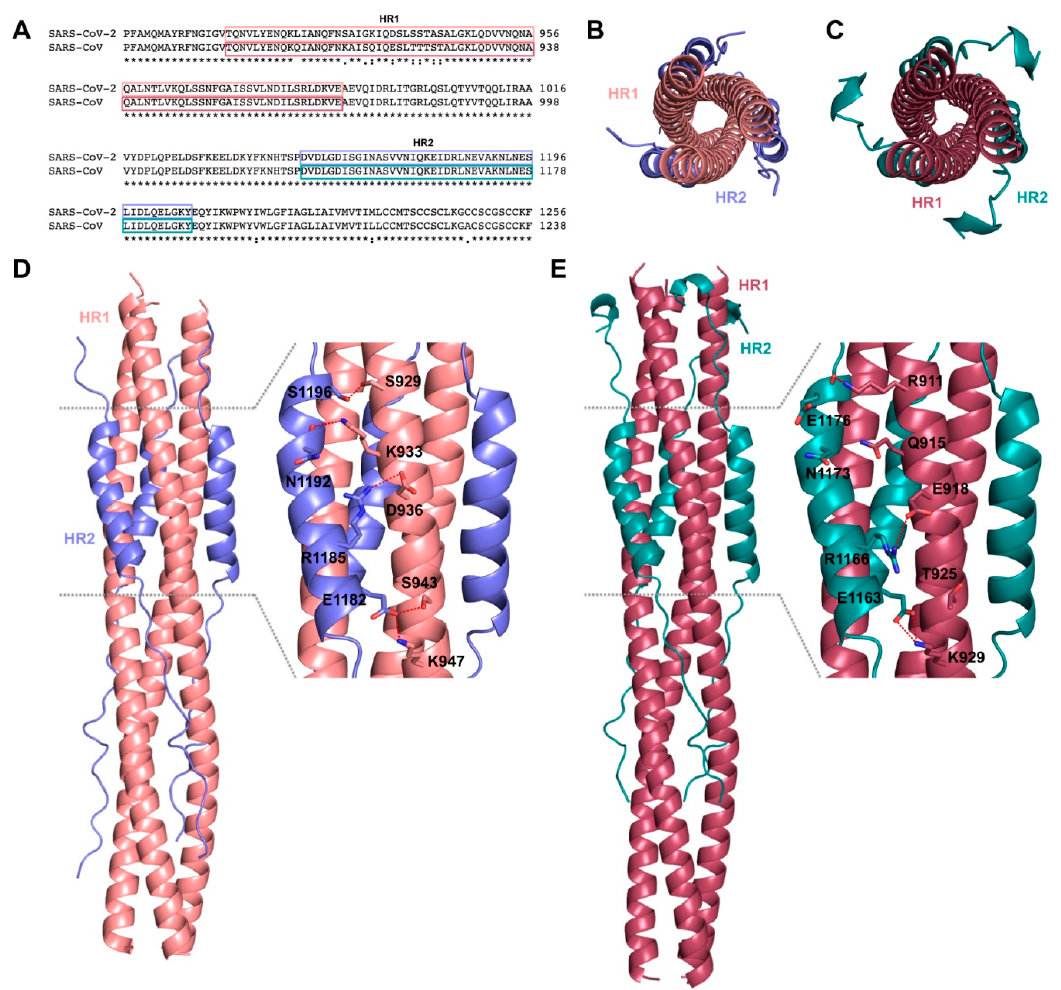
Figure 6. Comparisons of 6-HB fusion core in SARS-CoV-2 and SARS-CoV. ( A ) Sequence alignment between SARS-CoV-2 and SARS-CoV S proteins for the HR1 and HR2 regions, indicated with boxes colored salmon and raspberry for HR1 and slate and deepteal for HR2, respectively. Top view of the 6-HB fusion core structure of ( B ) SARS-CoV-2 (PDB ID: 6LXT) and ( C ) SARS-CoV (PDB ID: 1WYY) displayed as cartoon. The HR1 and HR2 domains are colored as in ( A ) and labeled. Side view of 6-HB of ( D ) SARS-CoV-2 and ( E ) SARS-CoV. A zoomed view of the interactions between HR1 and HR2, mediating fusion core formation, is shown on the right side. Key residues are displayed as sticks and labeled; hydrogen bonds and salt bridges are displayed as dashed red lines.